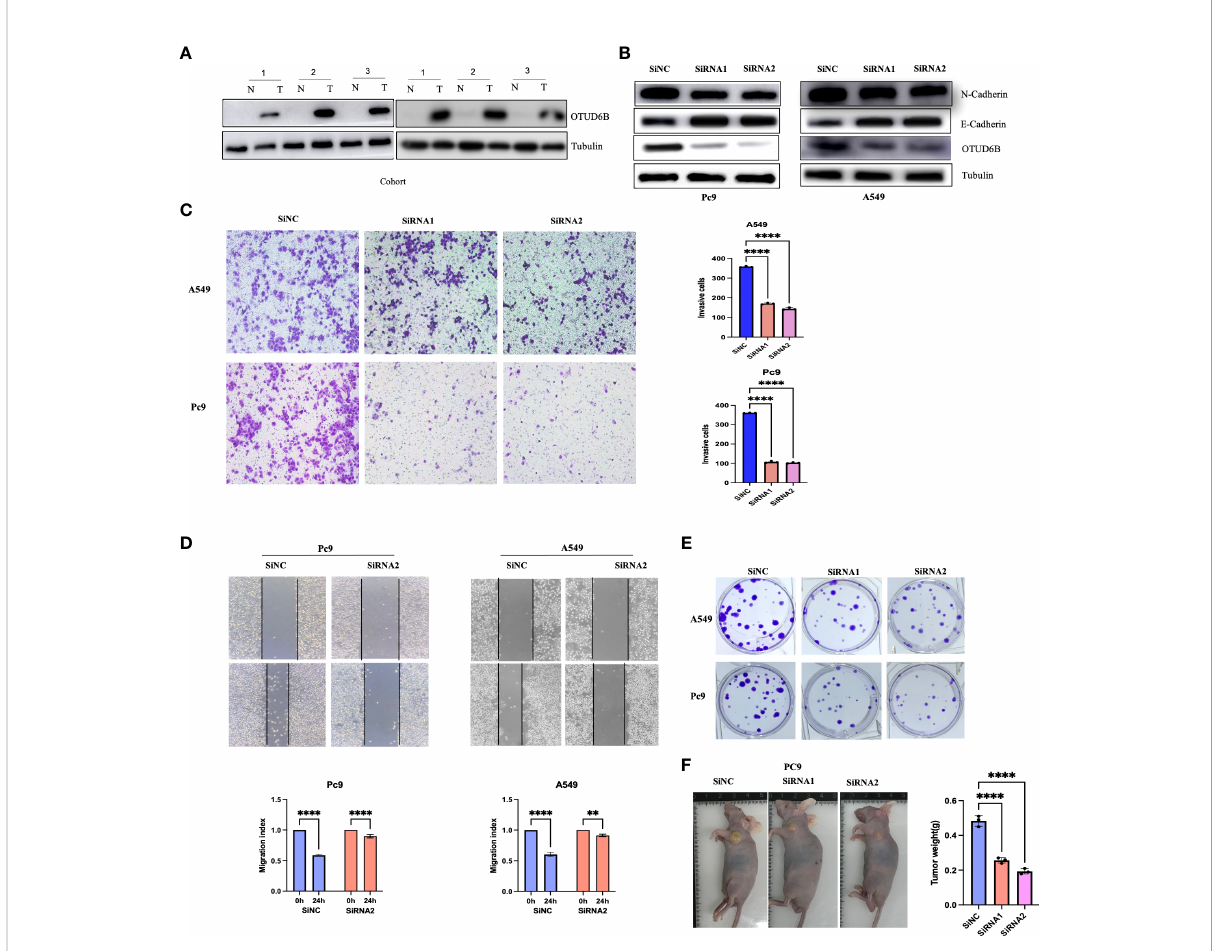
FIGURE 10 The knockdown of OTUD6B in lung cancer cells inhibits tumor self-renewal. (A) Immunoblot (IB) of OTUD6B expression in six randomly selected lung cancer samples (T) and their paired Normal (N) samples. n = 6 independent experiments. (B) Western blot validation of OTUD6B knockdown using siRNA in Pc9 and A549 cells. (C) Transwell migration assays in OTUD6B-knockdown Pc9 and A549 cells following transfection with the indicated siRNAs, typical images in the upper panels and invasive cell numbers in the lower panel. Scale bars, 70 m m. (D) OTUD6B knockdown inhibits Pc9 and A549 cell migration distance as seen in wound healing assays. (E) Cell proliferation detection of lung cancer cells was measured by clone formation. (F) Xenograft tumor models show that tumors grown from OTUD6B knockdown cells were smaller compared with those grown from control cells. (**p < 0.01; ****p <